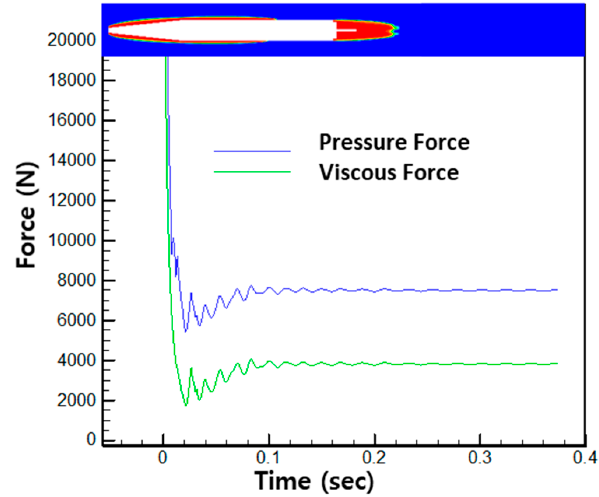
Figure 19. Analysis of drag unsteady state pressure force and viscous force at 70 m/s.